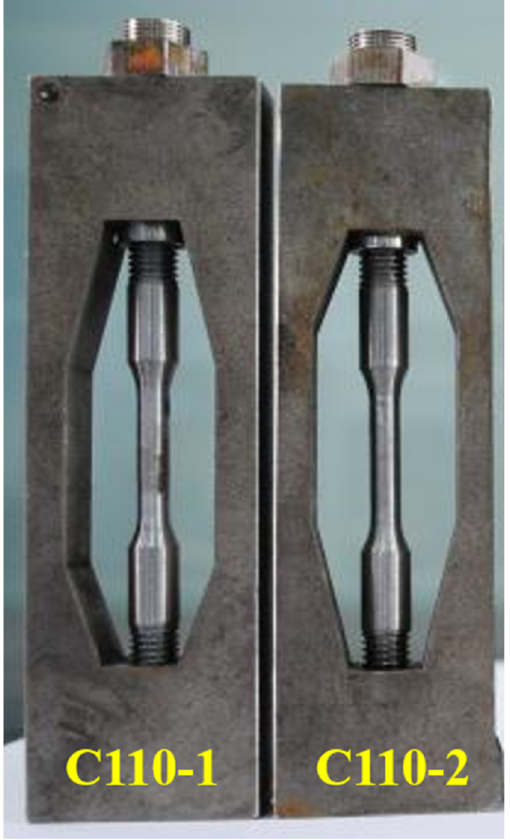
Figure 6. The constant-load device for plate fixture.